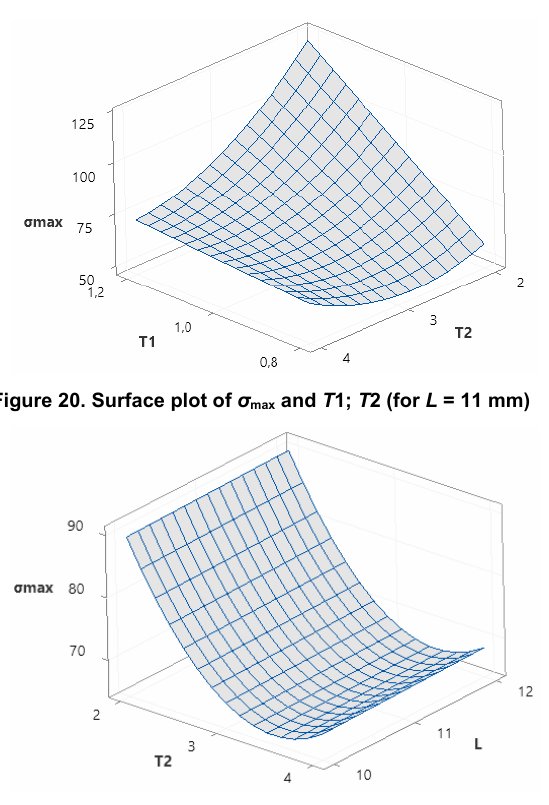
Figure 21. Surface plot of of σ max and T 2; L (for T 1 = 1